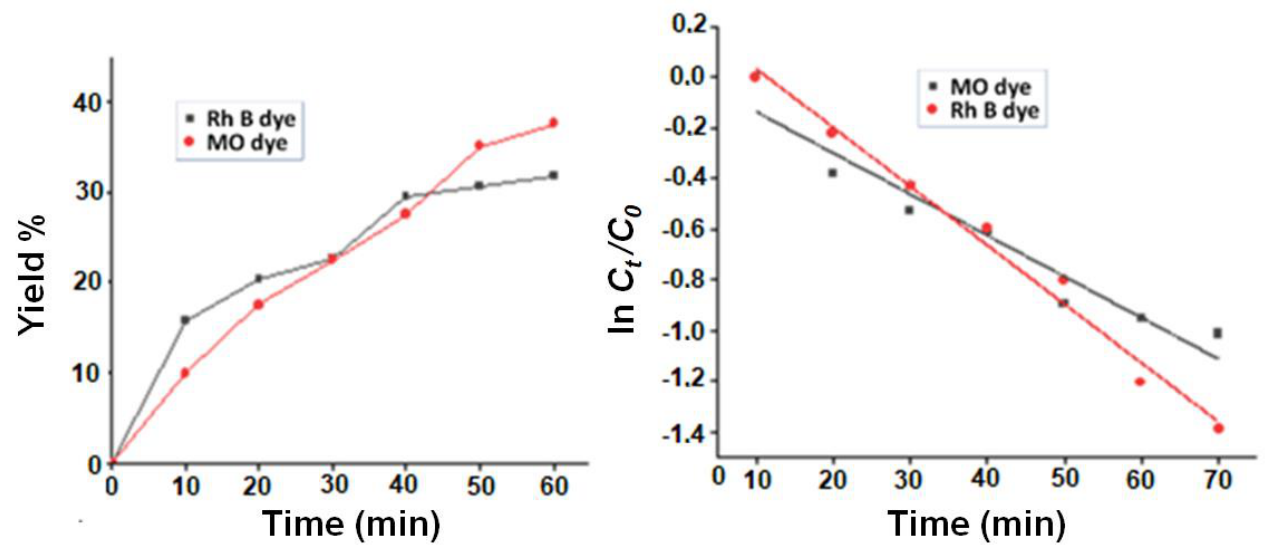
Figure 5. ( Left ) Changes in C t /C o versus time for the following conditions: MO + complex ( 4 ) and RhB + complex ( 4 ). ( Right ) Kinetics of complex ( 4 )-catalyzed photo degradation of MO and Rh B dyes in aqueous solution.